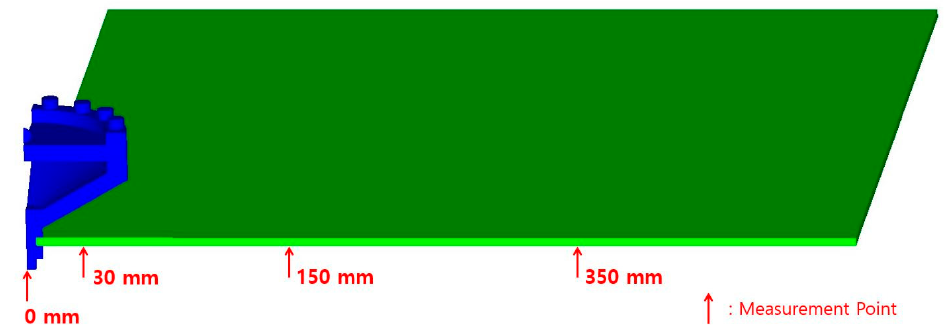
Figure 11. Acceleration calculation positions.